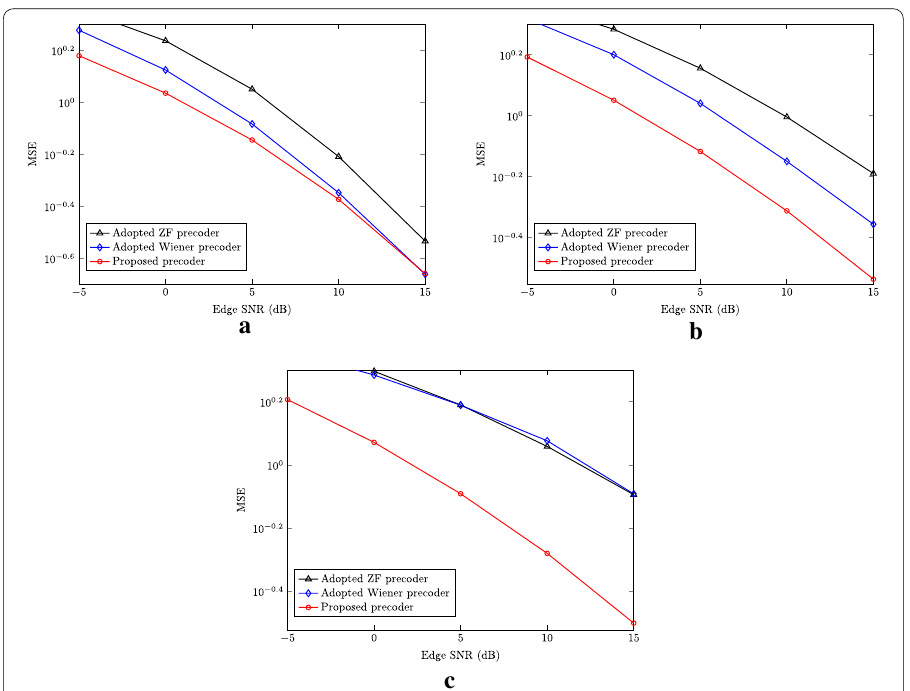
Fig. 5 Performance of the adopted ZF, Wiener and proposed precoders in terms of MSE in a receiver a